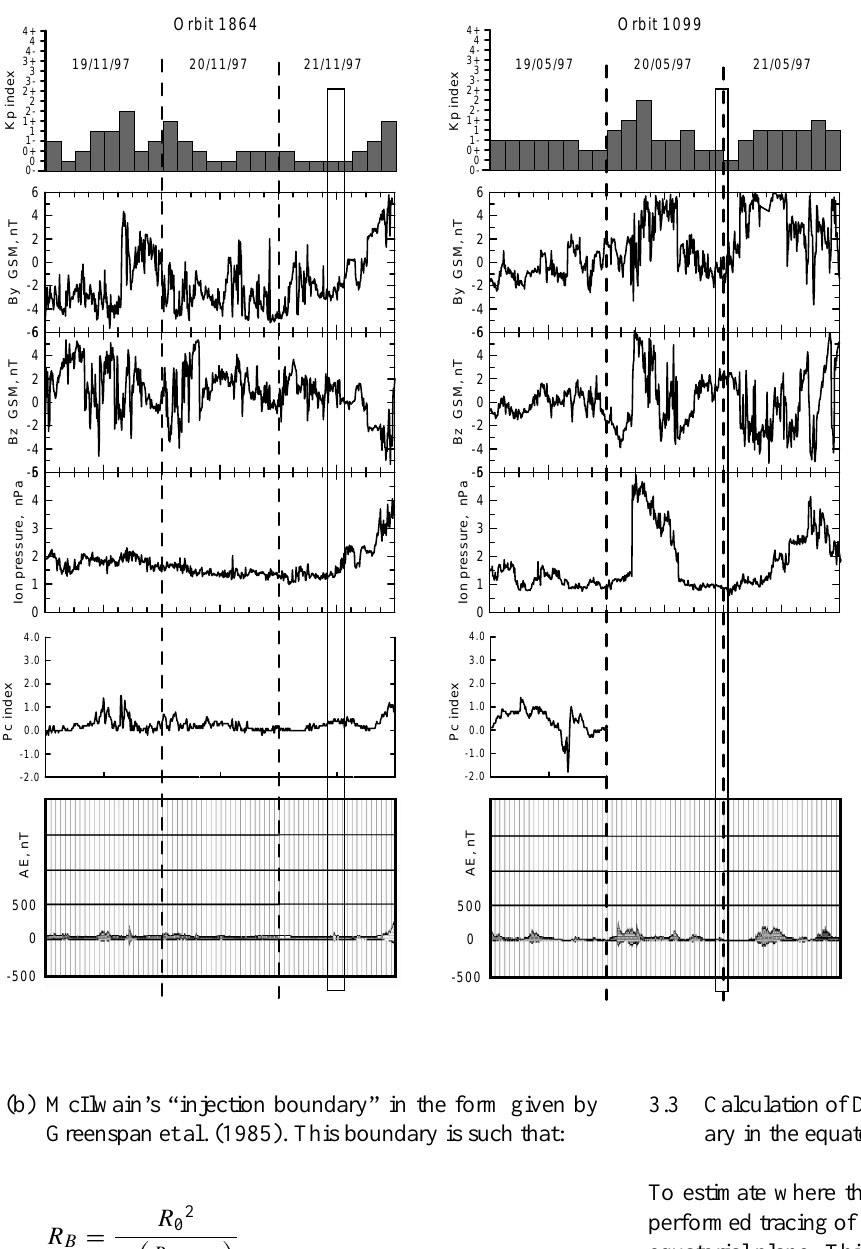
Fig. 2. Geomagnetic conditions for 19– 21 November 1997 (left column) and for 19–21 May 1997 (right column). From top to bottom: K p index, B Y GSM, B Z GSM, ion pressure of IMF, Pc index, AE index. Black horizon- tal bars indicate the intervals when the modeled ISGs were